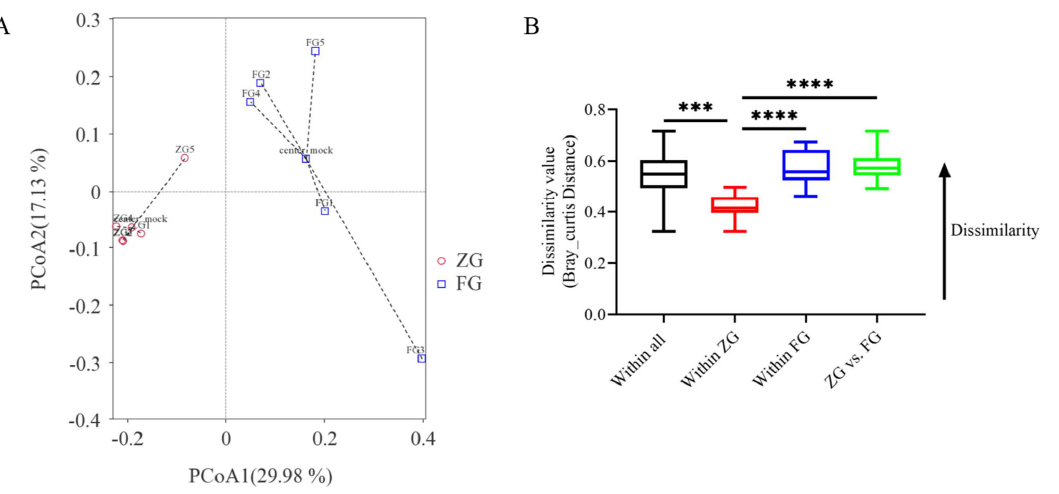
Figure 3. Differences in the cecal microbial composition between the two goose breeds. ( A ) Principal coordinate analysis (PCoA) plot showing cecal microbial compositional differences as quantified by ( B ) Bray–Curtis distance; ( C , D ) taxonomic compositions; n = 5. *** p < 0.001 and **** p < 0.0001 indi- cate significant differences between the ZG and FG. ZG, Zi goose; FG, Xianghai flying goose.